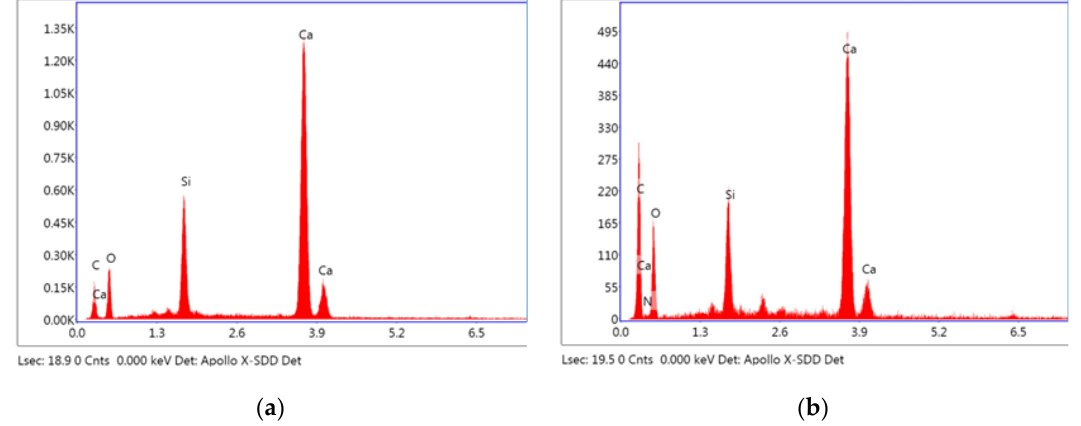
Figure 4. The EDS spot analysis of autolytic clinker microspheres ( a ) for point 1, ( b ) for point 2. Table 3. Mass distribution of major elements in different points from Figure 3d.